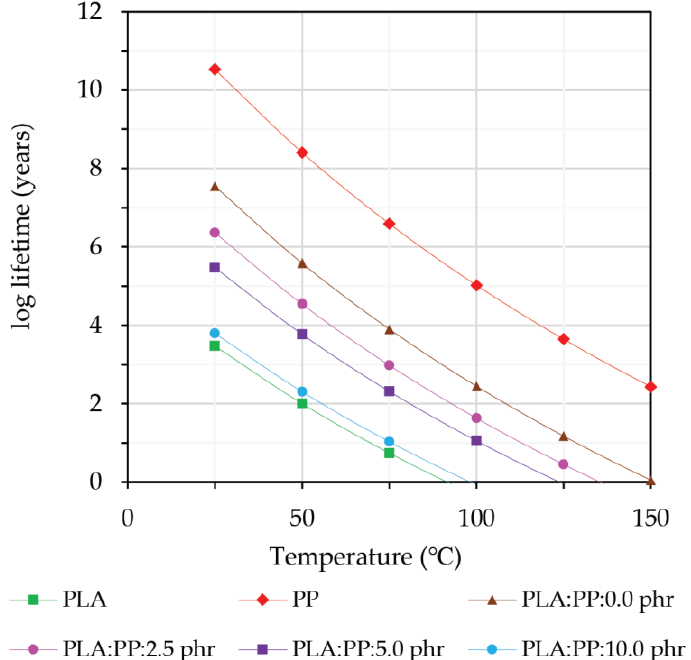
Figure 10. Thermal lifetime estimation for PLA, PP, and PLA/PP (70:30 wt%) without and with compatibilizer as obtained for different operating temperatures (T T ) at 20 °C/min and w = 0.05.